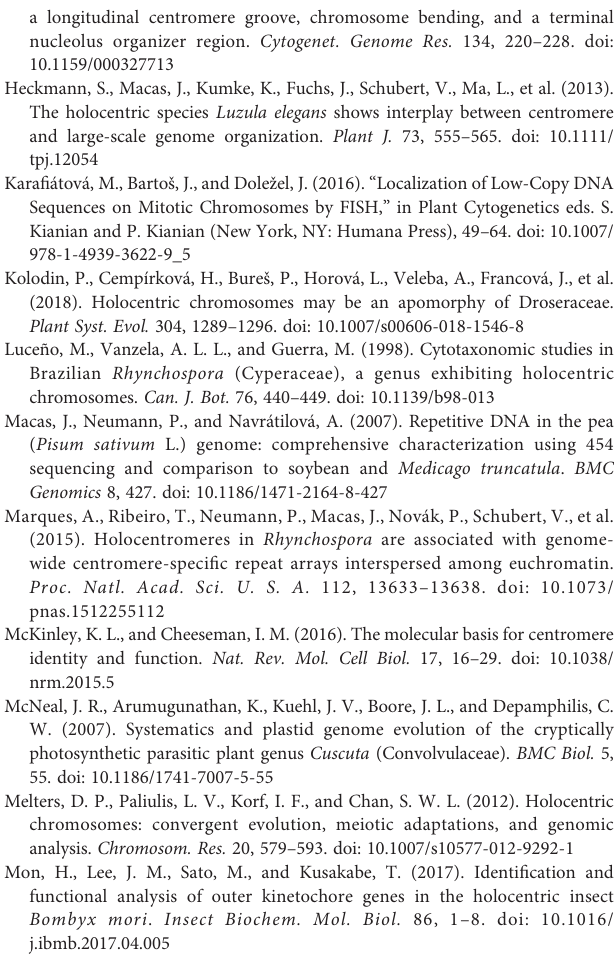
SUPPLEMENTARY TABLE 1 | Primers used for RT-PCR and RACE reactions.